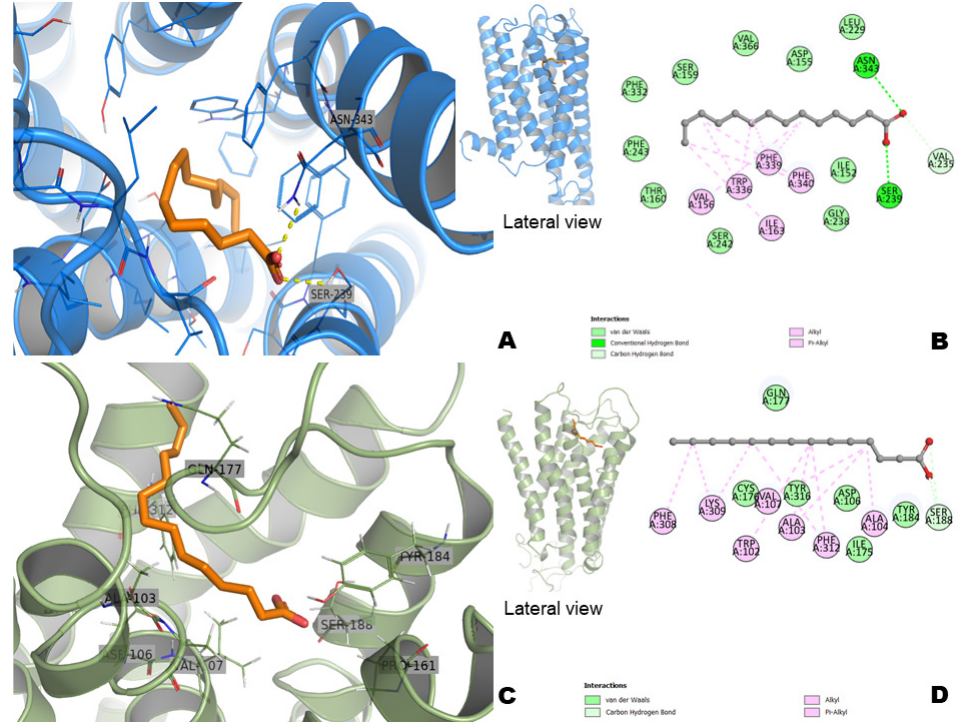
Figure 11 . The docking complexes of myristic acid with 5-HT2A ( A , B ) and α 1A -adrenergic receptor ( C , D ). Myristic acid is shown in stick representation (orange color). The elements are colored as follows: oxygen, red; nitrogen, blue; carbon, marine color to 5-HT2A and smudged color to α 1A - adrenergic receptor. Dashed lines (yellow color) represent the hydrogen bonds and van der Waals interactions (pink and pale green colors).